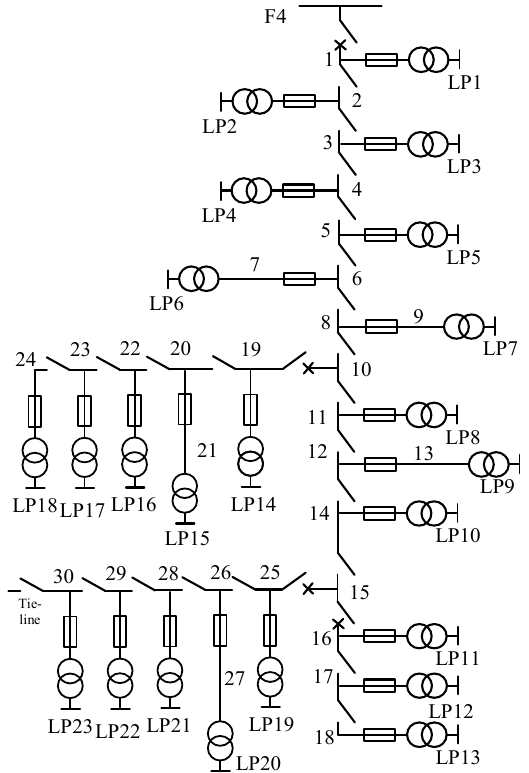
Figure 6. Topology of the test network.